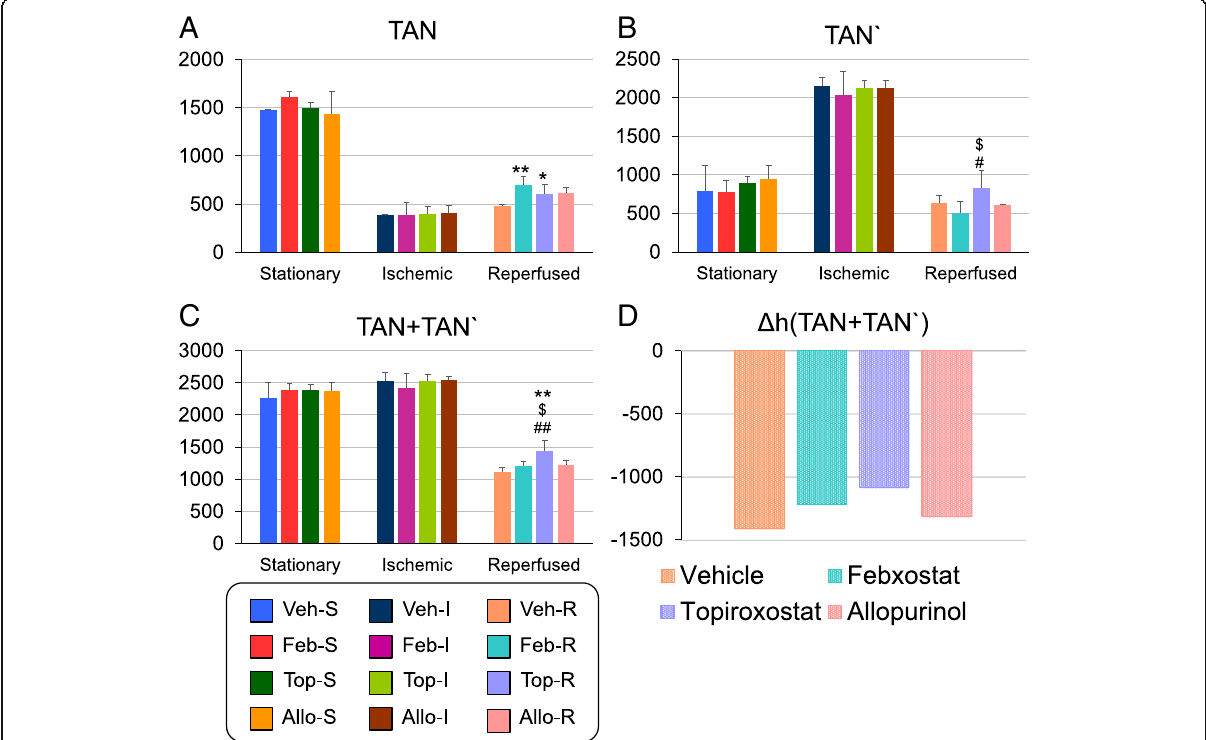
Fig. 4 Quantification of TAN, TAN', and TAN + TAN' by CE-TOFMS. a Quantitative CE-TOFMS data for TAN coincided with the HPLC results. b TAN' was increased at ischemic state in contrast to the decrease in TAN, and decreased again after reperfusion. c The values of TAN+TAN ’ did not significantly differ at stationary state among all groups and were well preserved at ischemic state; nevertheless, this parameter was decreased to as low as one half of that in the stationary state in the reperfused phase. d Δ hTAN + TAN' appeared to be lower in the febusostat and topiroxostat groups than in the vehicle and allopurinol groups. TAN = ATP + ADP + AMP), TAN = dATP + phosphoribosyl diphosphate (PRPP) + adenosine + adenine + inosine + IMP + hypoxanthine + xanthine + uric acid, Δ hTAN + TAN' was calculated as the TAN + TAN' of the reperfused state minus that of the ischemic state. Concentrations are expressed as nmol/g wet weight; the data are presented as the mean ± SEM ( n = 5/6). * P < 0.05 and ** P < 0.01 versus Veh; $ P < 0.05 versus Feb; #P < 0.05 and ## P < 0.01 versus Allo; one-way ANOVA followed by Games – Howell ’ s